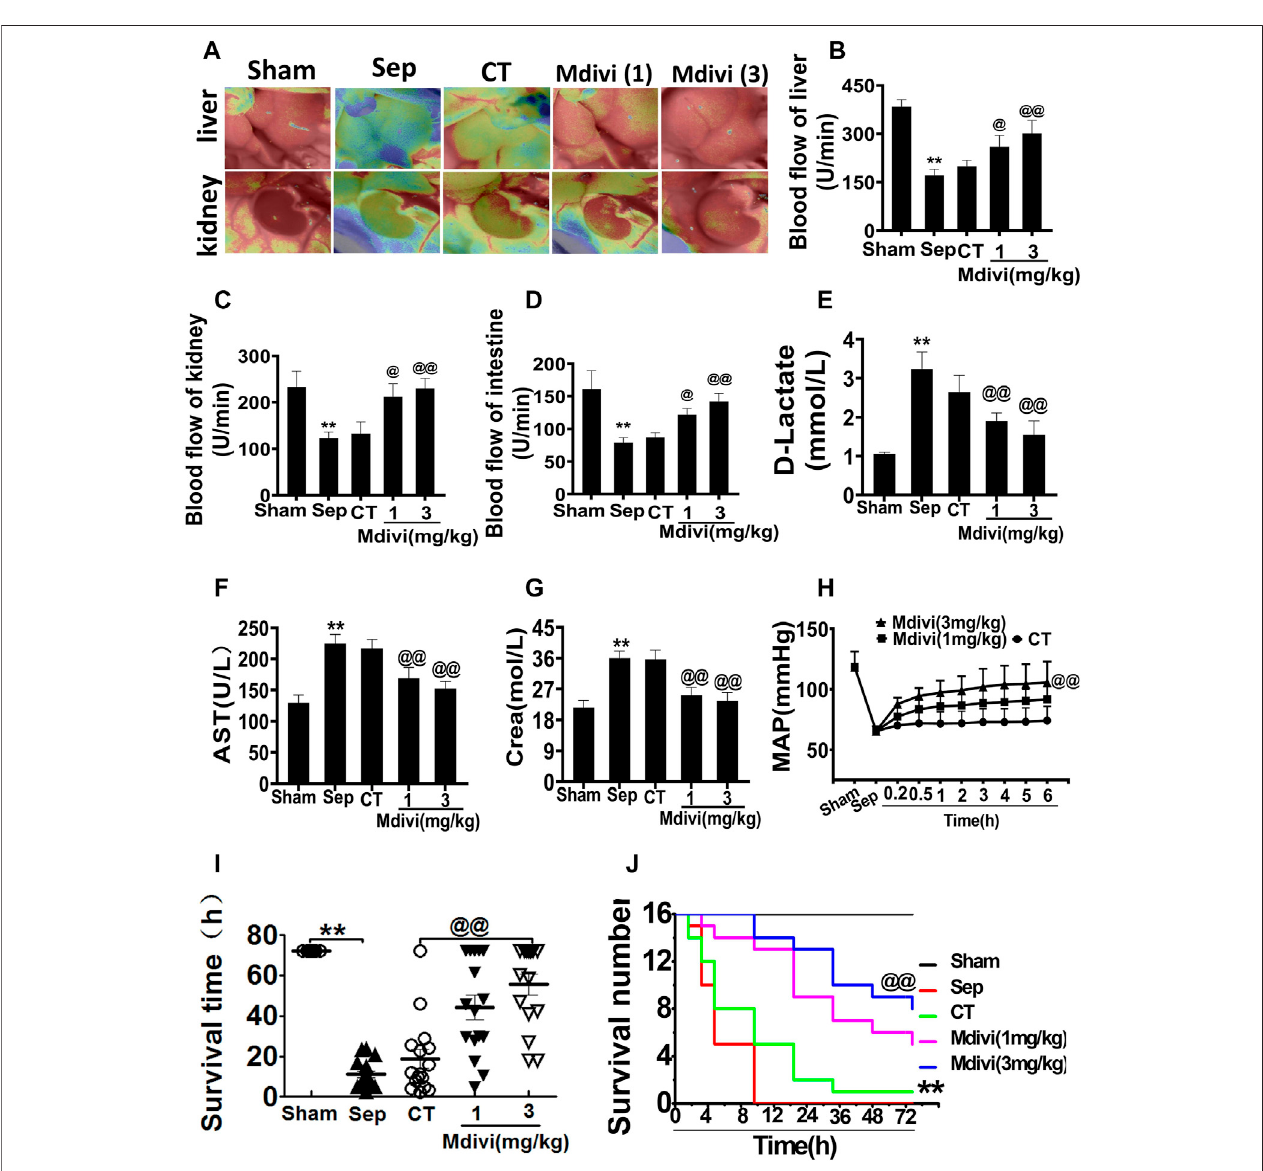
FIGURE2| EffectsofMdivi-1onvitalorganfunctioninsepticrats. (A) :blood fl owofliverandkidneywiththePeriCamPSISystem. (B – D) :blood fl owofliver,kidney and intestine with laser Doppler imaging. (E) : intestinal function (D-lactate). (F) : aspartate aminotransferase (AST). (G) : kidney function creatinine (Crea). (H) : Time-lapse monitoring of mean arterial pressure after Mdivi-1 treatment. After CLP 12h, the mean arterial blood pressure (MAP) was monitored after administration of 12 min, 30 min,1,2,3,4,5and6 hbyfemoralarteryintubation. (I,J) :EffectsofMdivi-1onsurvivalinsepticrats( n (cid:1) 16).Ratswererandomlydividedinto5groups,after6 h of treatment, blood vessels were ligated, muscle and skin layers were sutured, and the average survival time and survival rate of rats within 72 h were observed. * * p < 0.01 versus Sham. @ p < 0.05 and @@ p < 0.01 versus conventional treatment (CT) group. Sham (cid:1) the control group, Sep (cid:1) sepsis, CT (cid:1) conventional treatment. 1: Mdivi-1 (1 mg/kg). 3: Mdivi-1 (3 mg/kg).